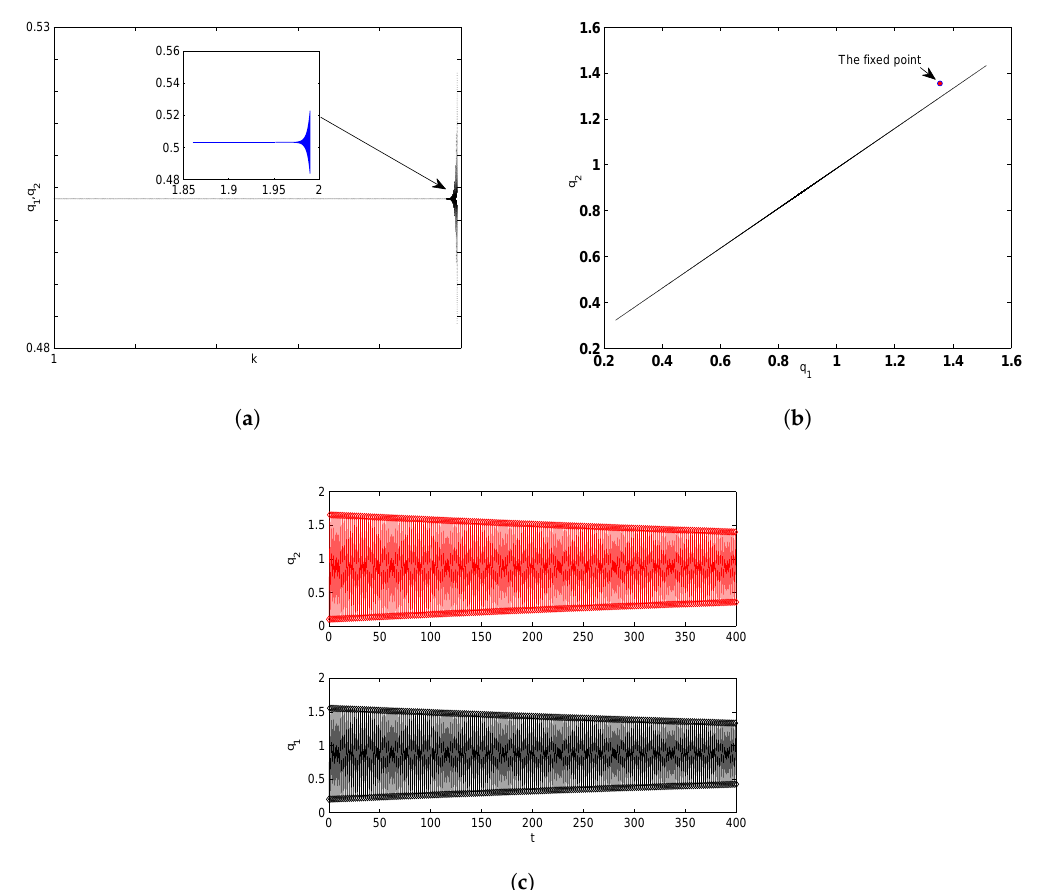
Figure 8. ( a ) bifurcation diagram when varying the parameter k ; ( b ) the fluctuations around the fixed point at k = 1.999; ( c ) time series for the fluctuations in ( b